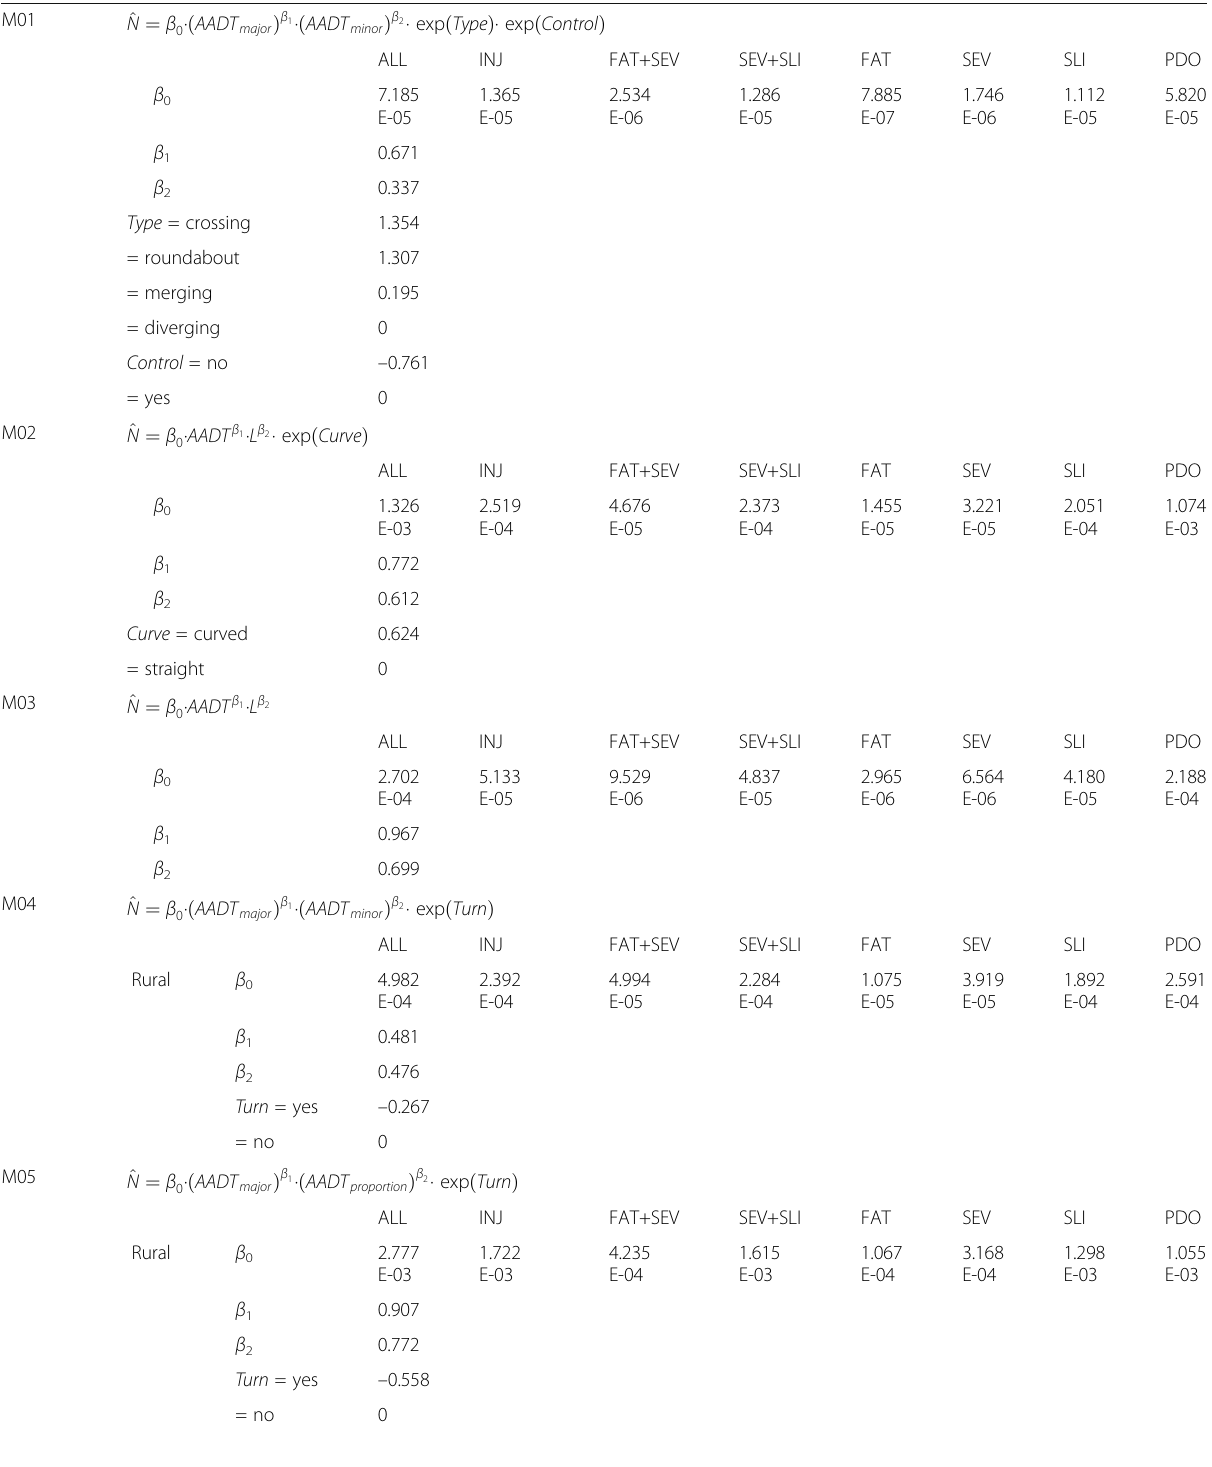
Table 5 Regression parameters of developed accident prediction models